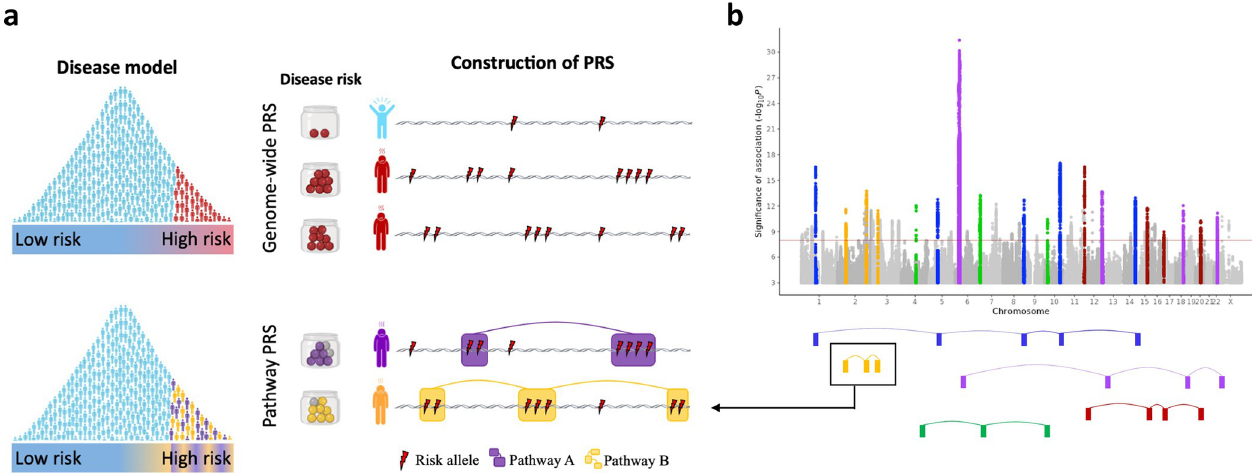
Fig 1. The pathway polygenic risk score approach. Coloured boxes represent genes, lines link genes that are within the same genomic pathway. A, Upper model: Classical polygenic model of disease, in which individuals lie on a linear spectrum from low to high risk and genome-wide PRSs are constructed as the sum of risk alleles across the genome. Disease risk depicted by the Jar model [18]. Lower model: Pathway polygenic model of disease, in which there are multiple liabilities and PRSs are constructed by aggregating risk alleles over different genomic pathways. B, GWAS results Manhattan plot illustrated as a hypothetical composite of signals, where each signal corresponds to an alternative functional route to disease. Pathways that only make a small contribution to disease risk across the population, or a contribution in a small fraction of individuals (e.g. nicotine receptor pathway in those individuals who smoke), are likely to harbour risk variants of relatively small effect. Figure partially created with